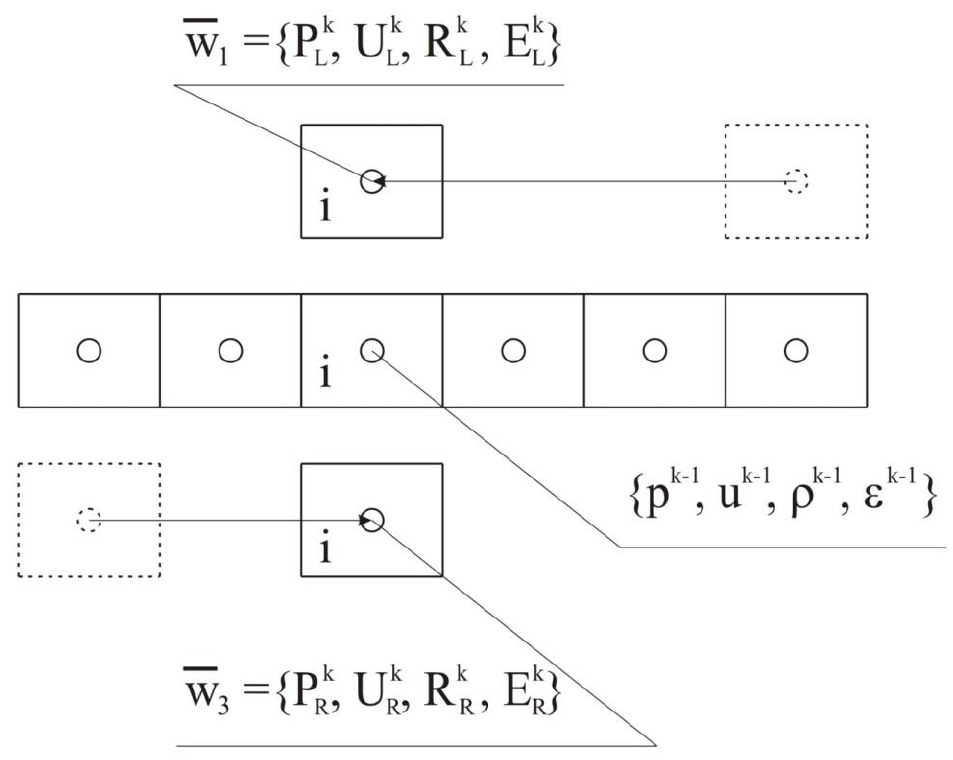
Figure A1. Initial conditions for the three Riemann problems.